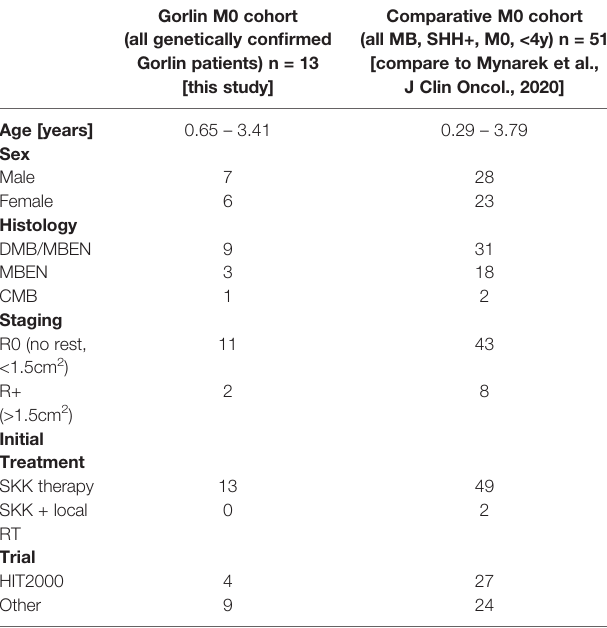
TABLE 2 | Patient characteristics for the Gorlin M0 Cohort (all genetically diagnosed PTCH1 and SUFU associated Gorlin syndrome patients) vs . the Comparative M0 Cohort (all medulloblastomas (MB), SHH+, M0, <4y). Gorlin M0 cohort (all genetically con fi rmed